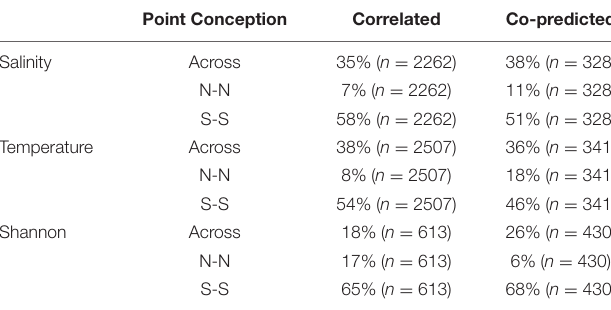
TABLE 1 | Percentages of correlated and co-predicted (number of unique station pairs in parantheses) for salinity, temperature, and Shannon